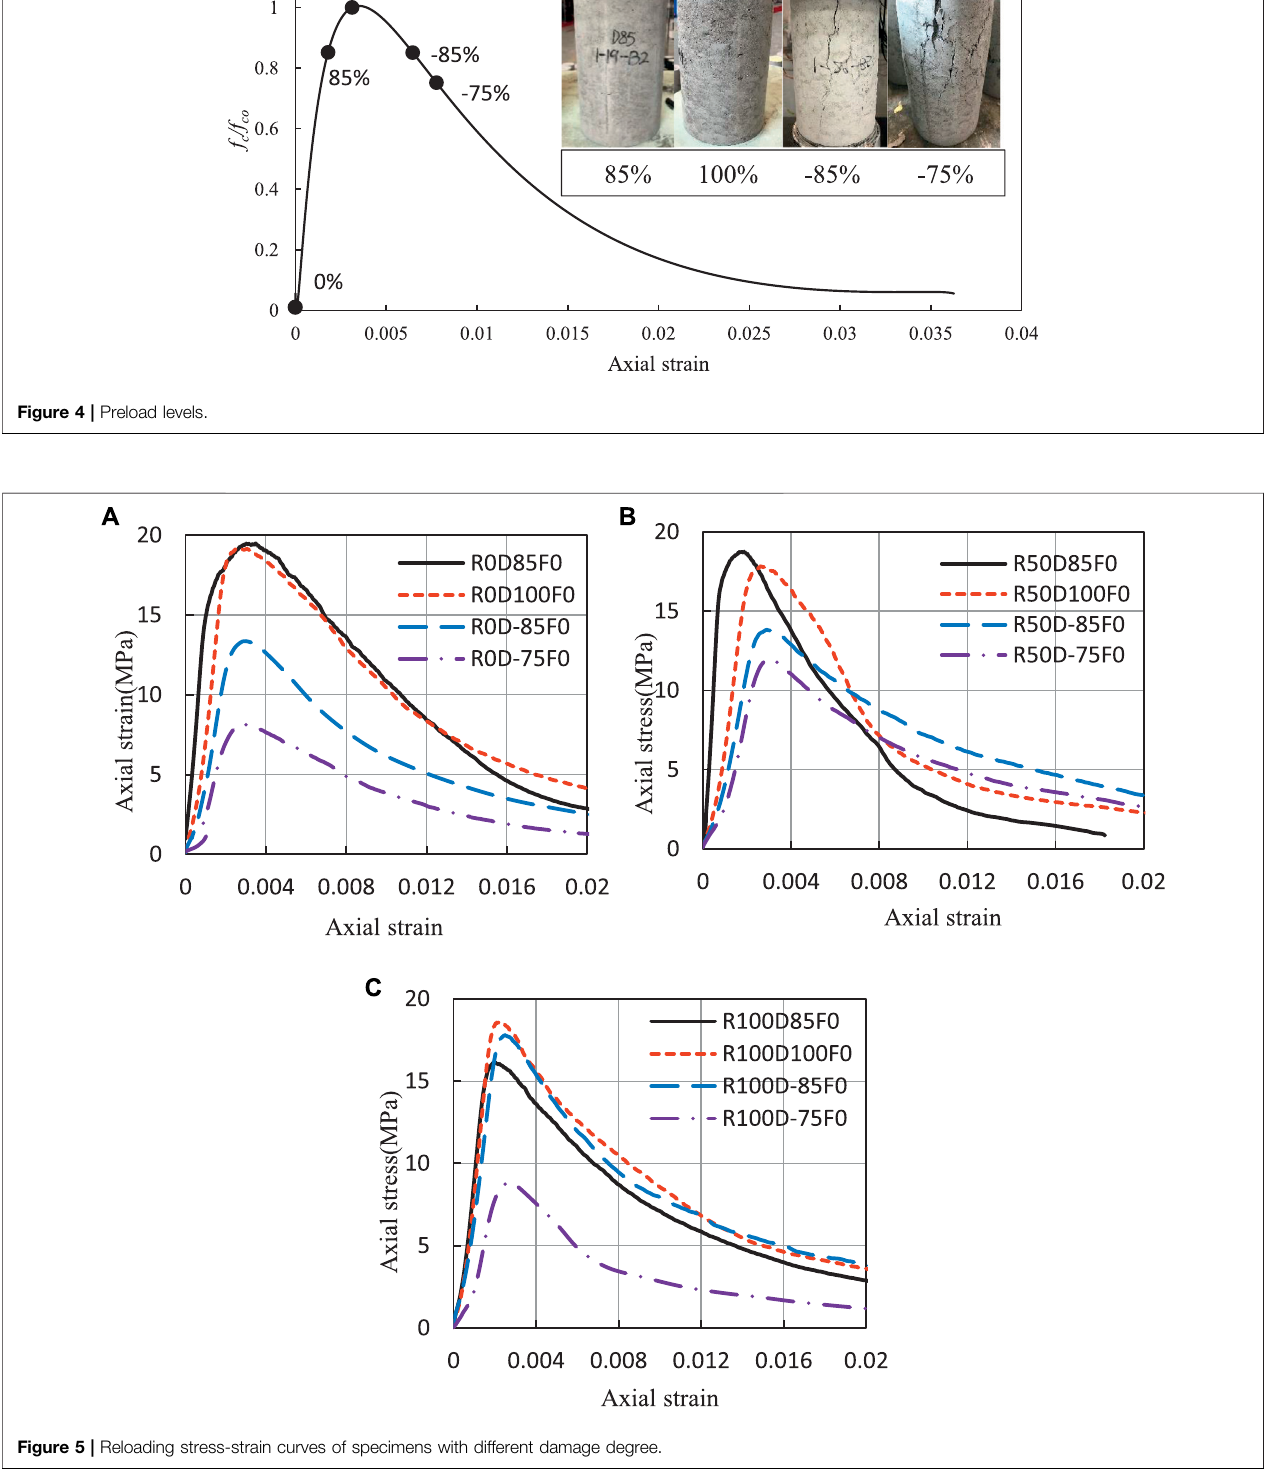
Frontiers in Materials |